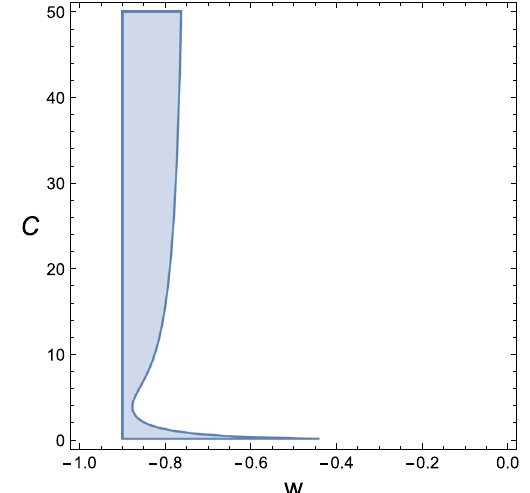
Fig. 2 Region plot for the critical point P 2 for the model s = − 2 for the constants C 1 = C 4 = 1 and C = C 5 C 3 . The figure is representing the regions where the critical point for that model (see Table 1) is stable. The point is never unstable. All the blank regions represents the regions where the point is a saddle